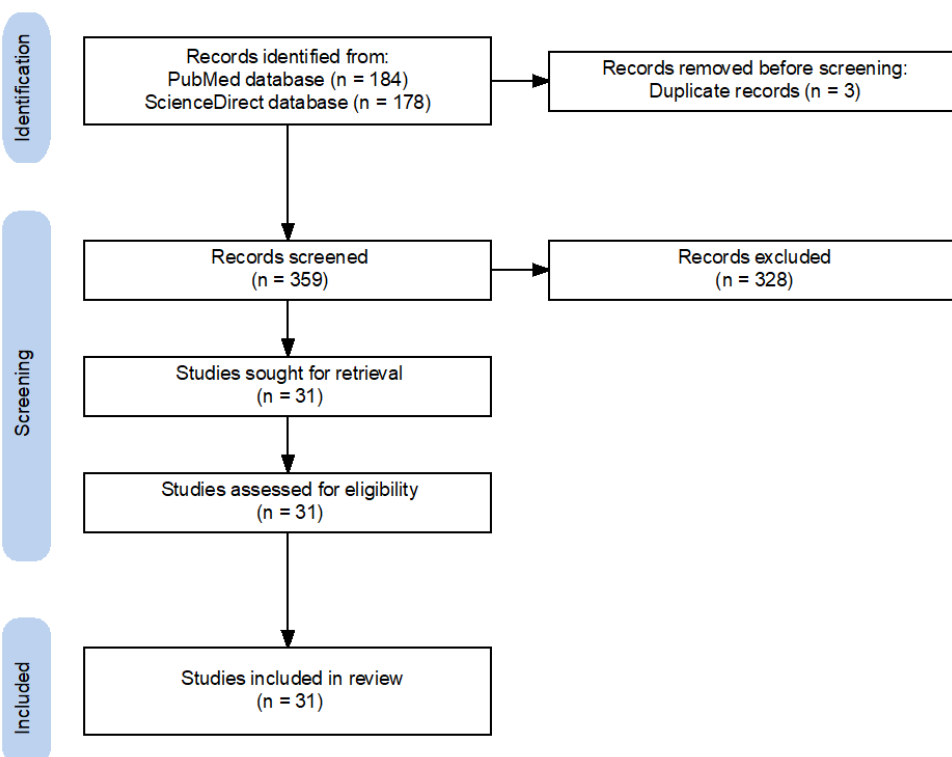
Figure 1. Preferred reporting items for systematic reviews and meta-analyses (PRISMA) flowchart of search strategy [27] .